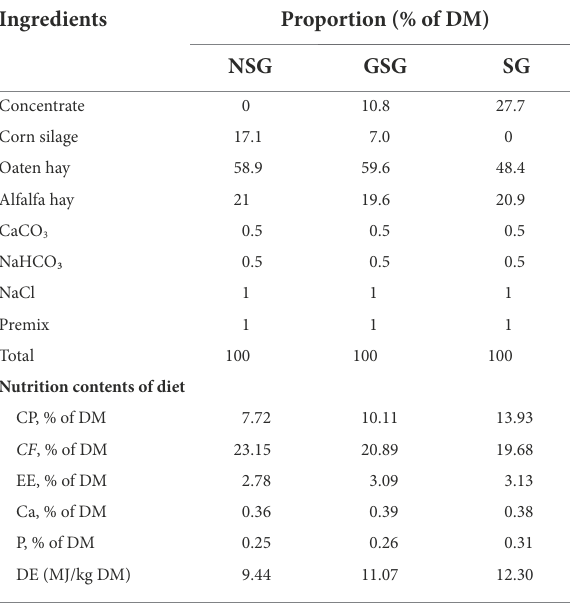
TABLE 1 Diet composition of three treatment groups.